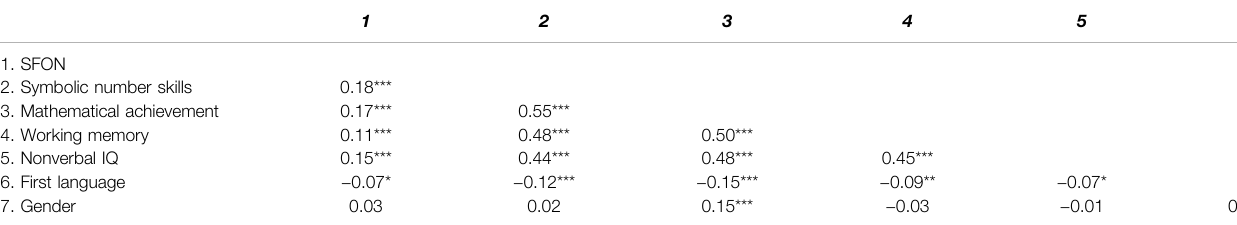
TABLE 3 | Correlations between all variables.